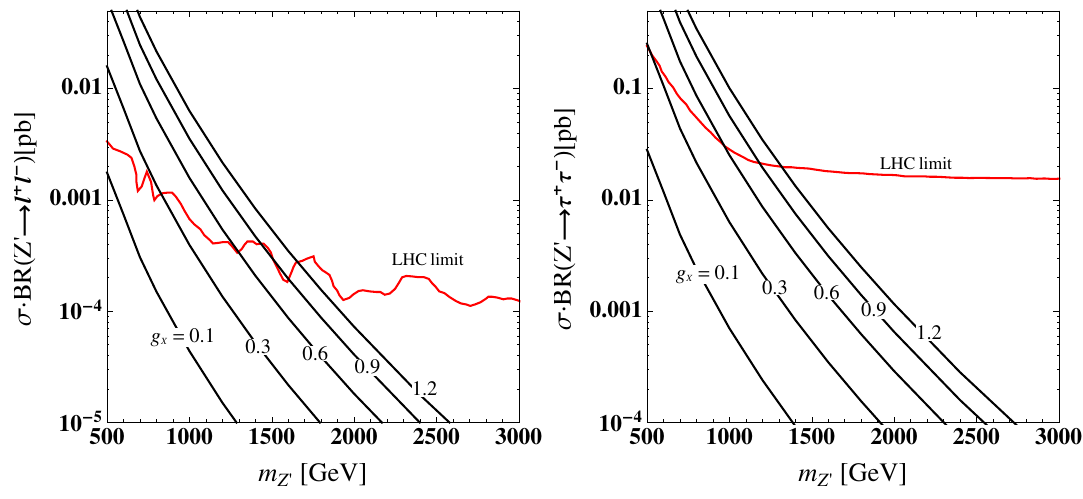
Figure 6 . Left (right) plot: (cid:27) ( pp ! Z 0 ) BR ( Z 0 ! ‘ + ‘ (cid:0) ( (cid:28) + (cid:28) (cid:0) )) with ‘ = e; (cid:22) for several values of g X compared with LHC limit; from refs. [72] and [73] for ‘ + ‘ (cid:0) and (cid:28) + (cid:28) (cid:0)